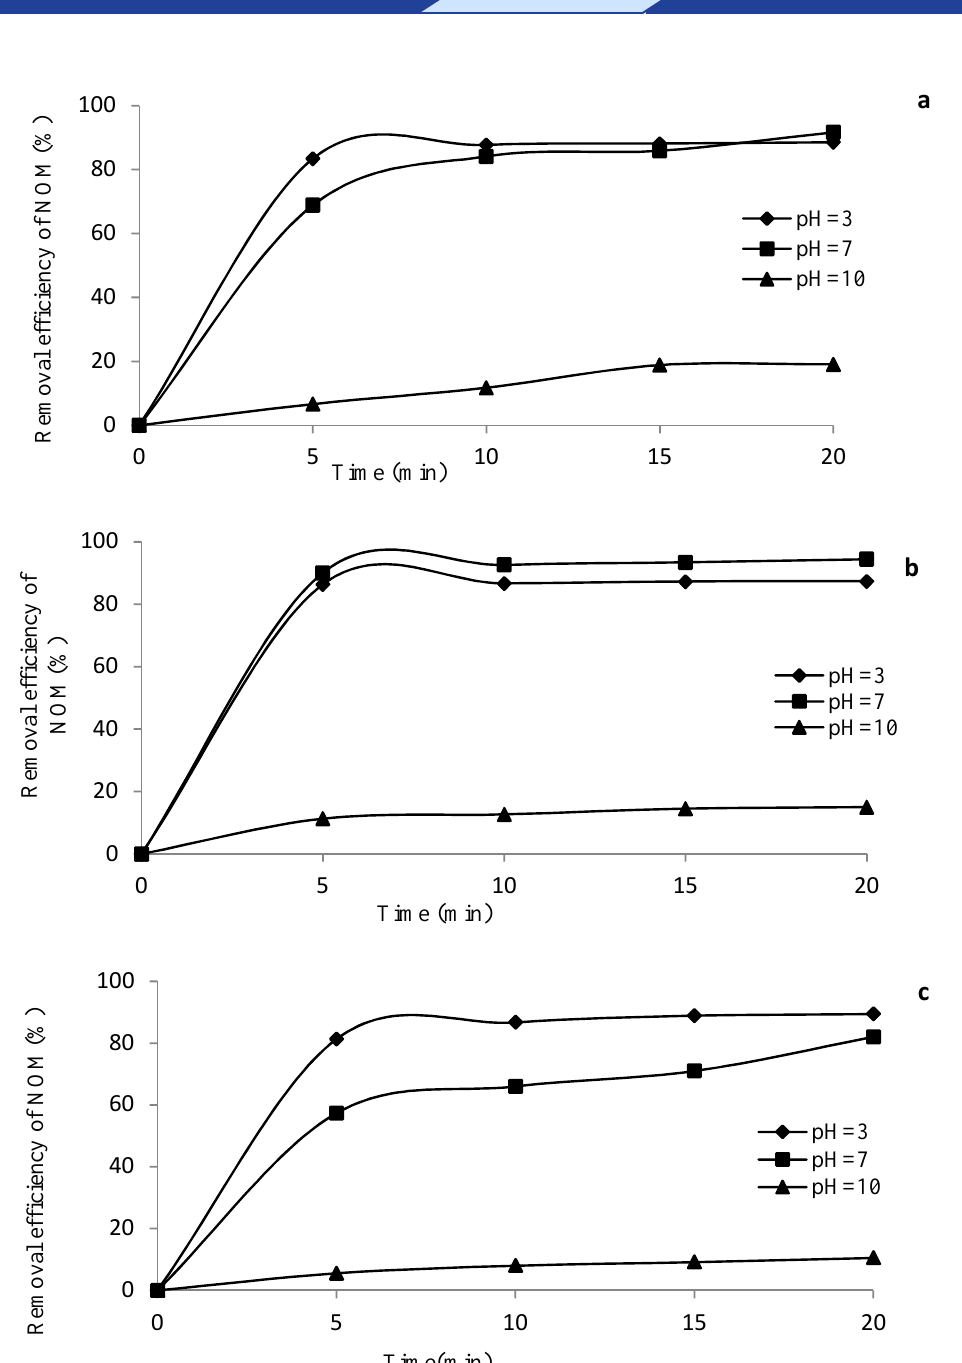
Figure 4. a: The effect of initial pH on natural organic matter (NOM) removal efficiency as a function of reaction time (condition: the applied current = 0.1 A, NOM concentration = 10 mg/l); b: The effect of initial pH on NOM removal efficiency as a function of reaction time (condition: the applied current = 0.1 A, NOM concentration = 25 mg/l); c: The effect of initial pH on NOM removal efficiency as a function of reaction time (condition: the applied current= 0.1 A,